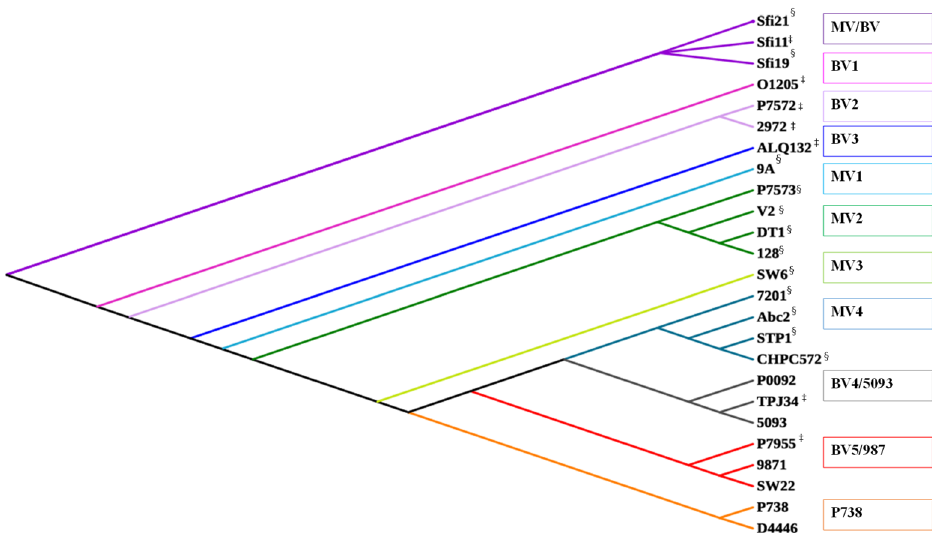
Figure 3. Proteomic tree of the replication proteomes of 25 representative phages. Moineauvirus -specific replication modules are colored light blue (MV1), mid-blue (MV4), dark green (MV2) and light green (MV3). Brussowvirus -specific replication modules are highlighted in bright pink (BV1), lilac (BV2), and dark blue (BV3). A module that is shared among certain members of both Brussow- and Moineauvirus, 5093 or 987 members is indicated in deep purple (MV/BV), grey (BV4/5093) or red (BV5/987), respectively. The replication module proteome of P738 is unique and represented in orange. § denotes Moineauviruses; ‡ denotes Brussowviruses; the 5093 phages are represented by 5093 and P0092; the 987 group are represented by 9871 and SW22; and the P738 group are represented by P738 and D4446.